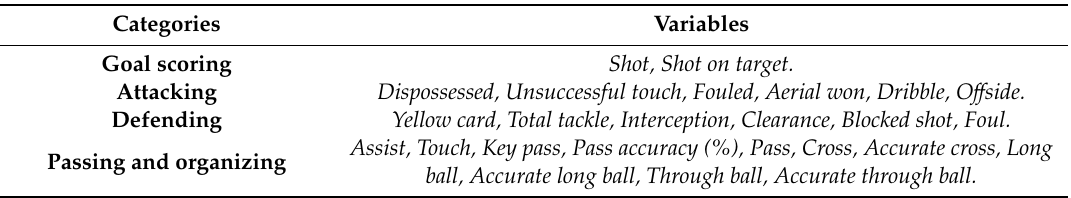
Table 1. The classification of technical